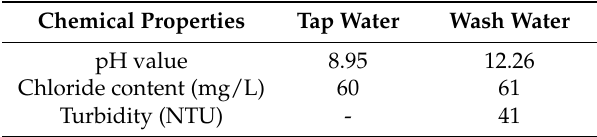
Table 4. Chemical analysis of tap water and wash water.